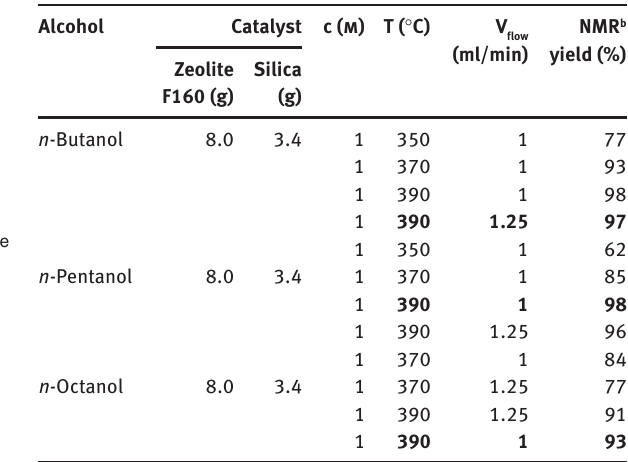
Table 2: Reaction parameters and results with n -alcohols. a